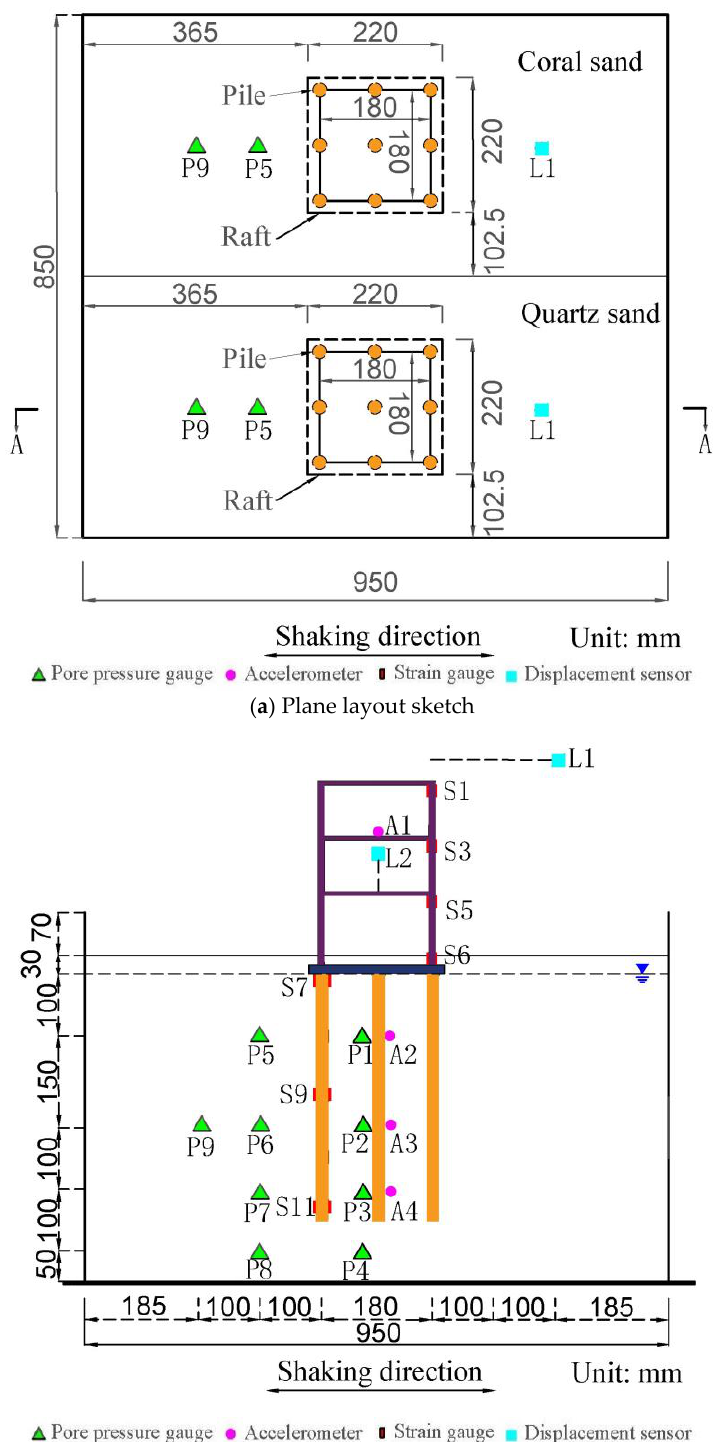
Figure 4. General configuration of model tests. Table 3. Summary of shake table tests conducted.